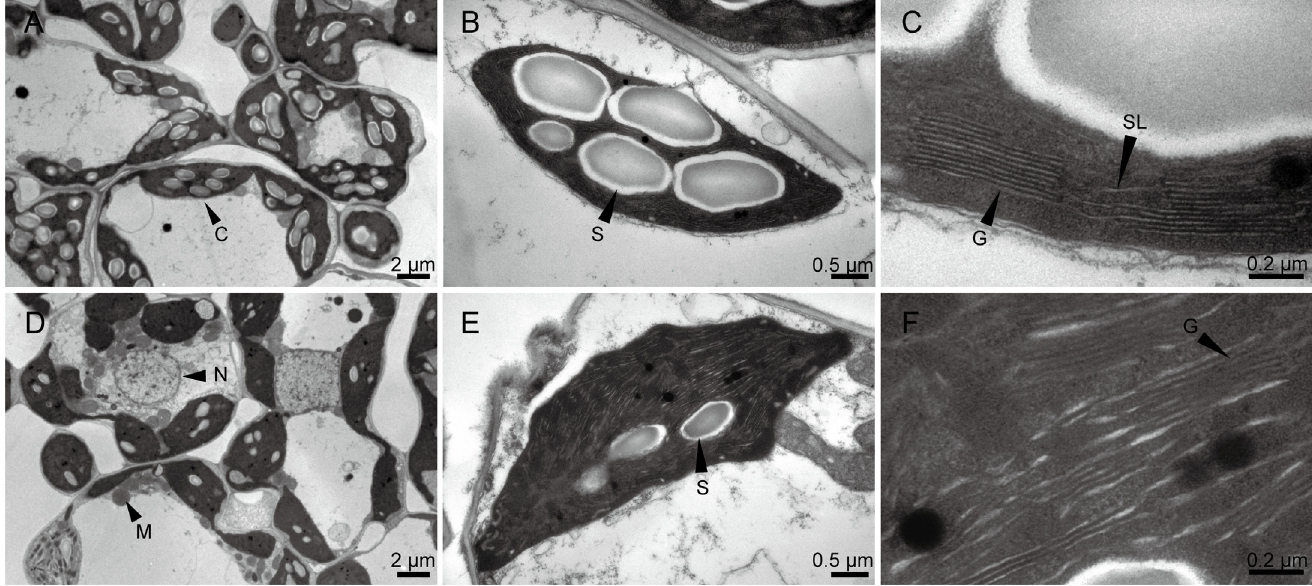
Fig 2. Chloroplast ultrastructure of IR64 and w67. A-C, 4-week-old IR64; D-F, 4-week old w67; C chloroplast, M mitochondria, N nucleus, S starch granule, G granum, SL stroma